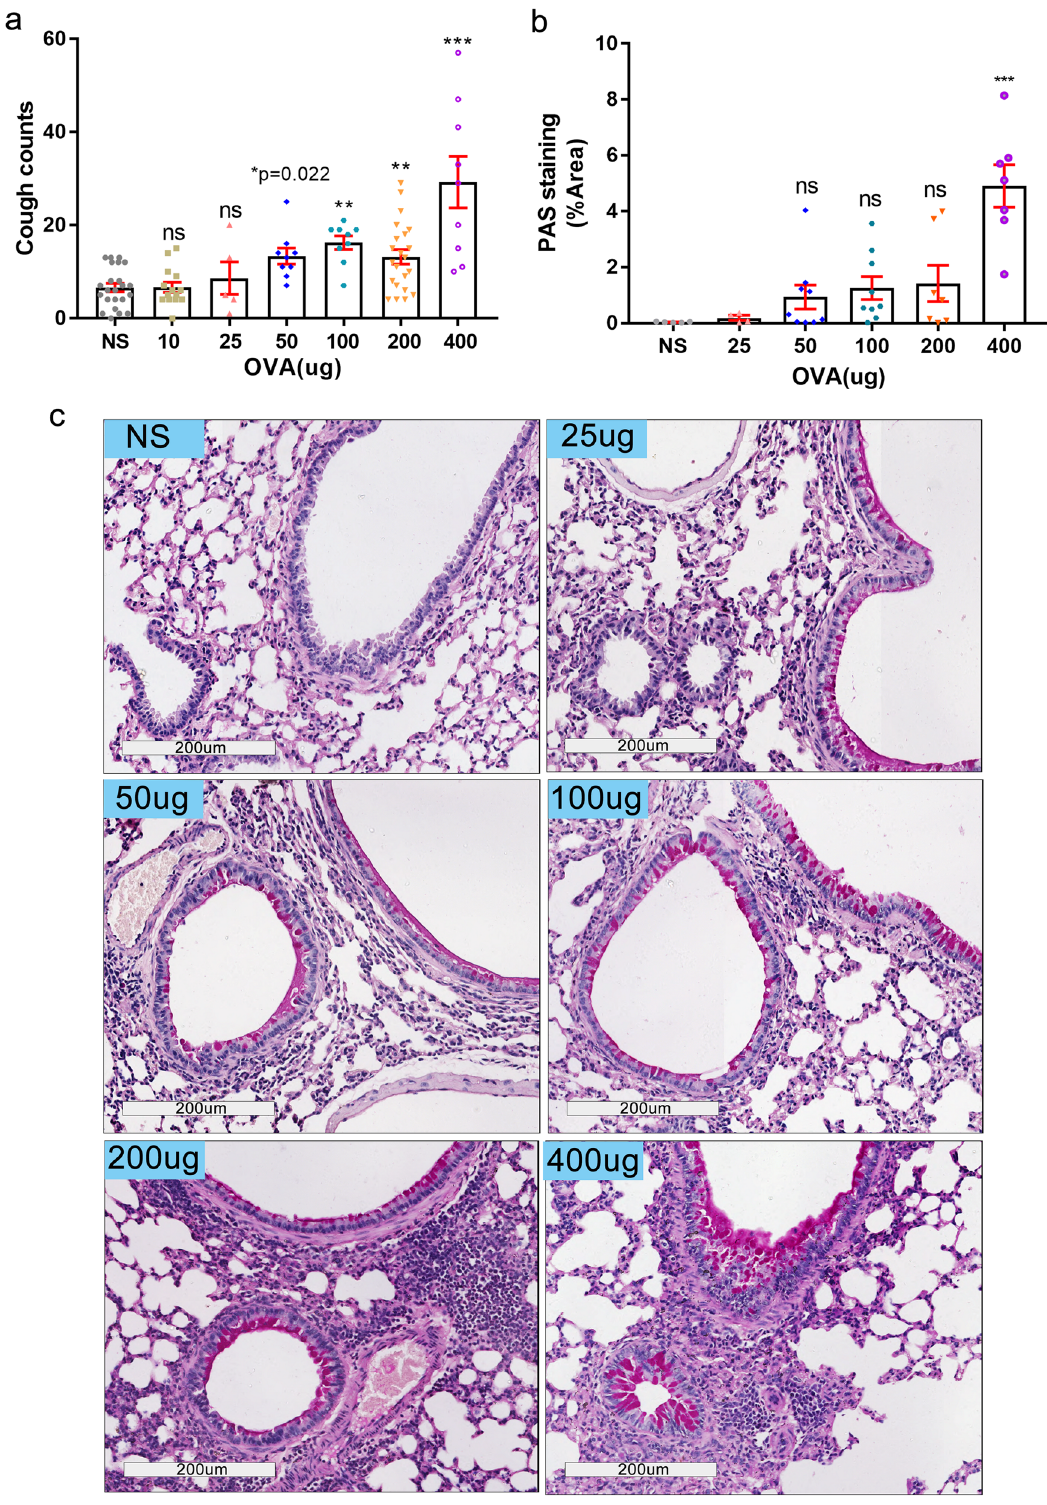
Figure 4. Cough frequency and goblet cell hyperplasia in lung tissue after OVA challenge. ( a ) 12 h after the last OVA challenge, atomized capsaicin (0.1 mmol/L) was used for cough stimulation, and the frequency of cough in mice of all groups was automatically detected using the Finepointe software and recorded. ( b , c ) The extent of goblet cell hyperplasia, a significant inflammatory factor leading to wet cough, was estimated by periodic acid-Schiff (PAS) staining. Semi-quantitation of PAS staining was shown as the positive staining area percentage after Image J software analysis ( b ) and representative views were shown in ( c ) (magnification 200 ×). (25 µg OVA dose, n = 5, other groups, n ≥ 9. * P ≤ 0.05; ** P < 0.01; *** P < 0.001; ns, no significance). The scale is indicated on the panel by the length of the box around the size in